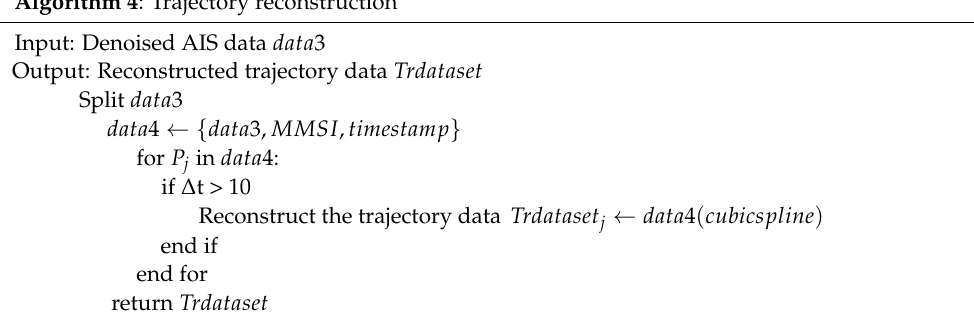
Algorithm 4 : Trajectory reconstruction